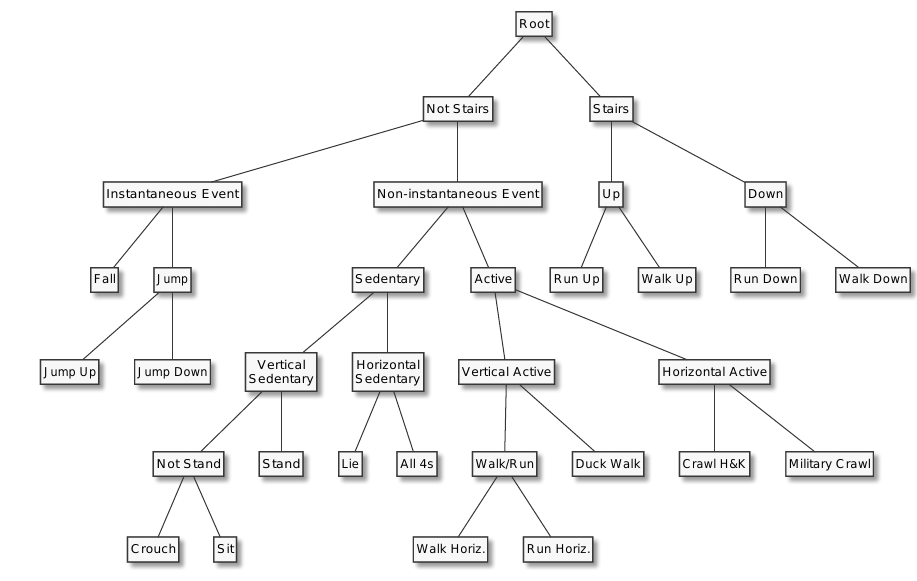
Figure A5. Expert hierarchy 5